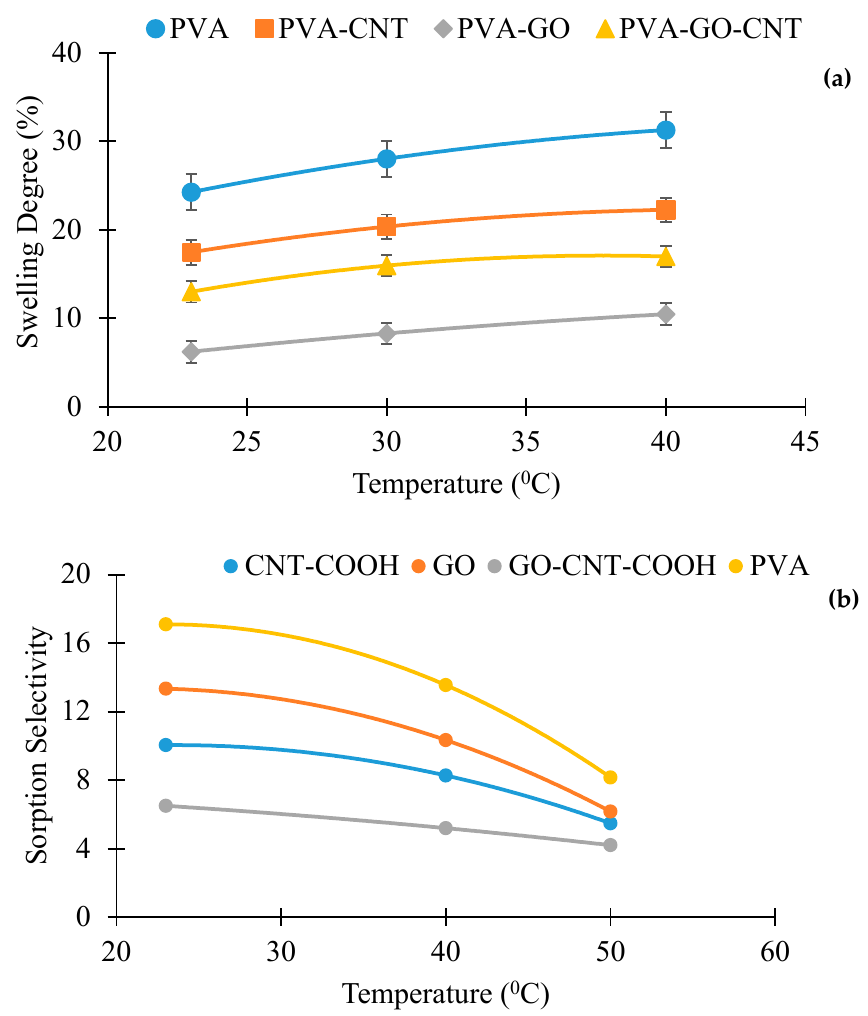
Figure 13. Swelling degree as a function of temperature with 15% water (85% ethanol) in the feed mixture and its corresponding sorption